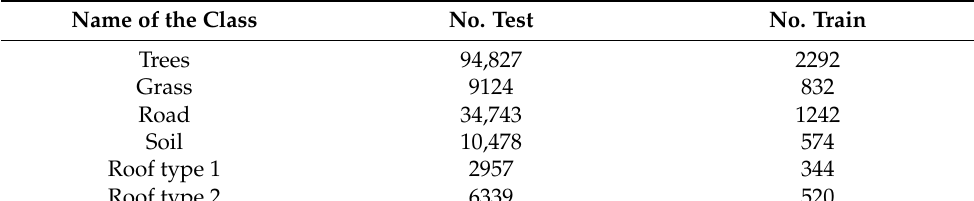
Table 1. The number of test and train pixels of Pleiades image.